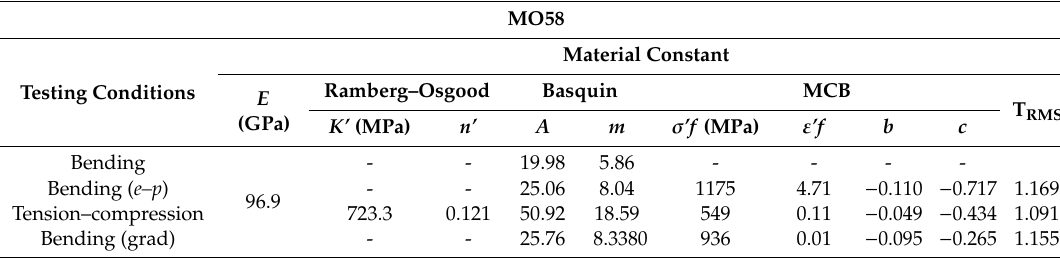
Table 7. Cyclic properties of MO58 steel.